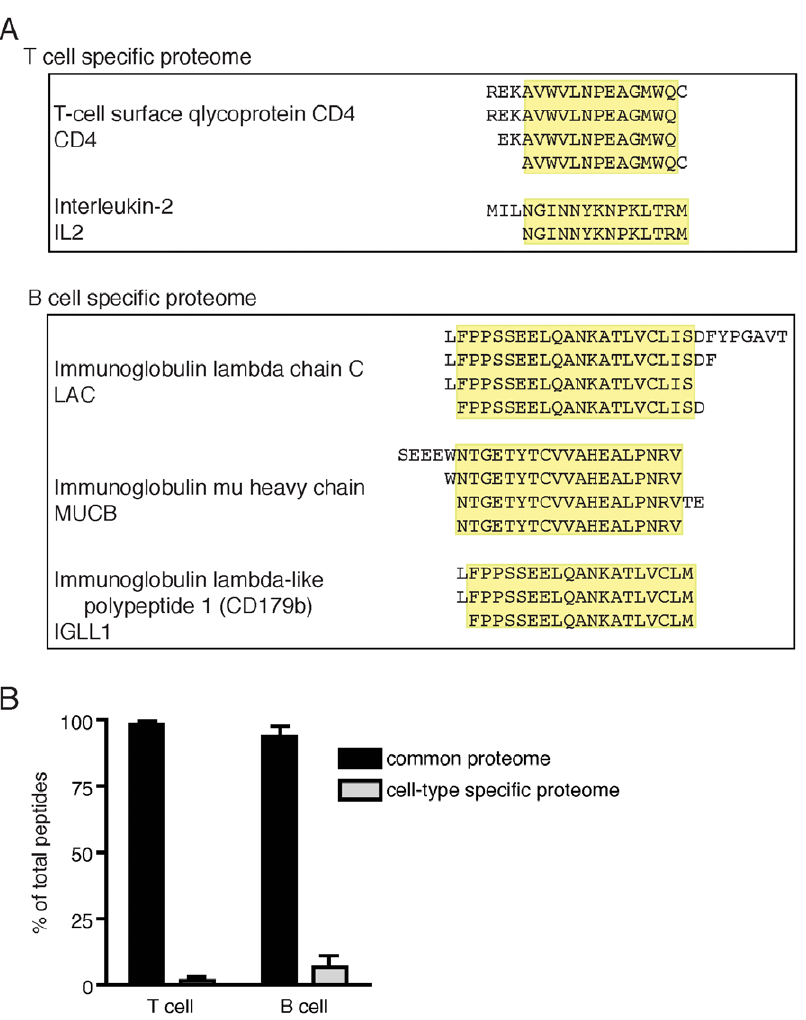
Figure 3. Self-peptides identified from the cell-type specific proteome include key signaling receptors such as CD3, CD4 and the B cell receptor. A . Cell-type specific nested peptide sequences isolated from T cells and B cells (donor 1). Predicted core binding sequence is indicated in yellow. B . Frequency of peptides derived from the common (on non-cell-type specific) proteome and the cell-type specific proteome in T cells and B cells. Experiments were performed in triplicate (for T cell clones) and in duplicate (for B cell lines) using cells prepared from donor 1 (mean 6 SD).